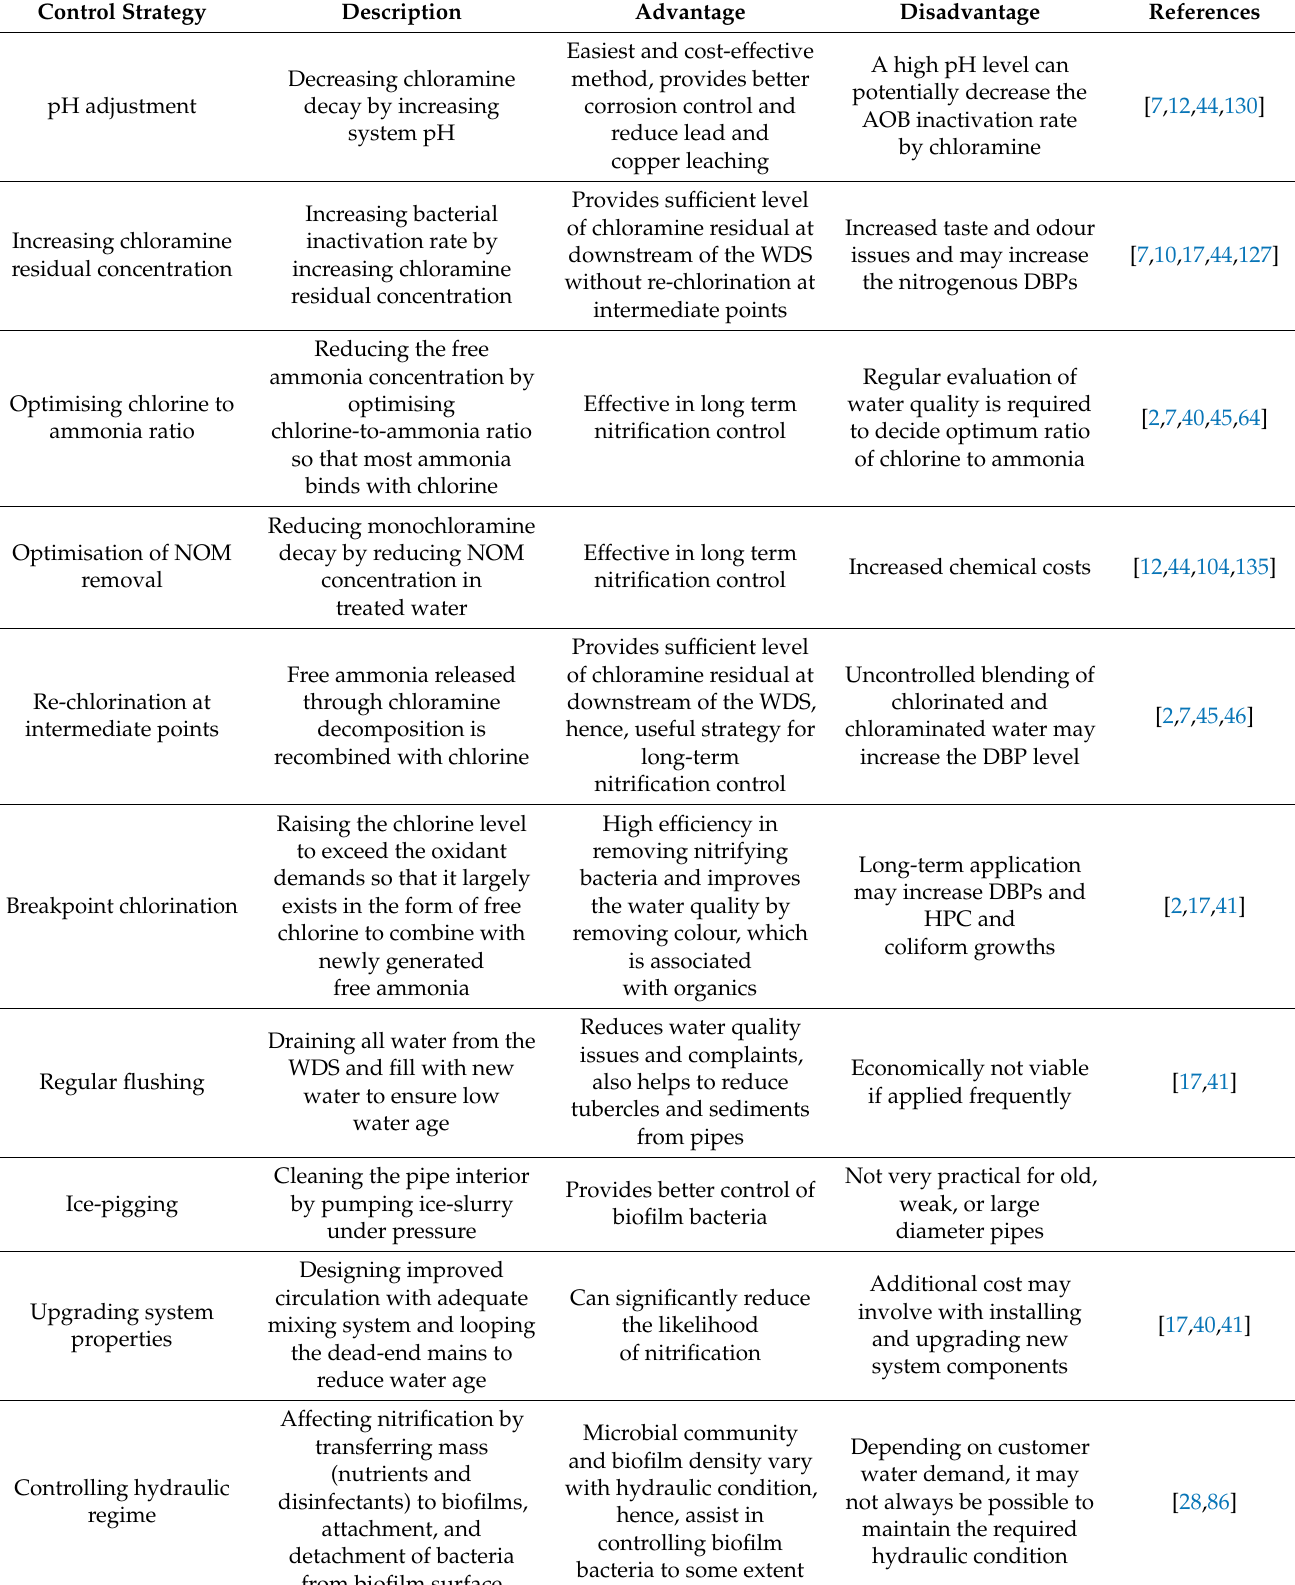
Table 5. Summary of nitrification control strategies in